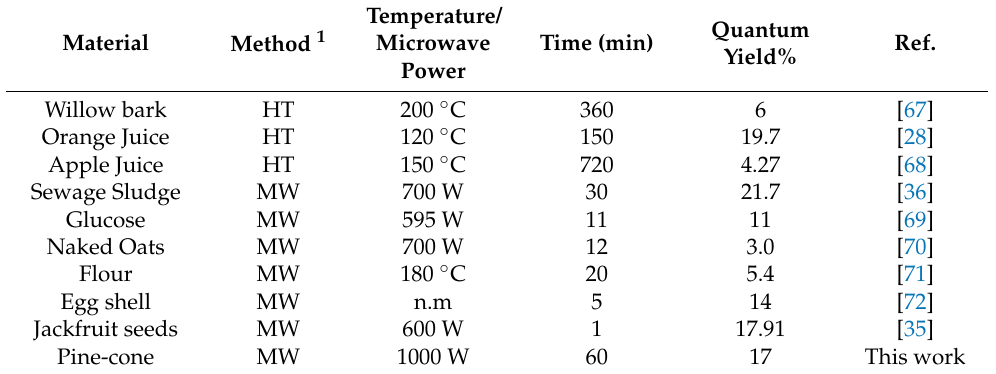
Table 1. Comparison of various methods in CD preparation from different carbon precursors and their quantum